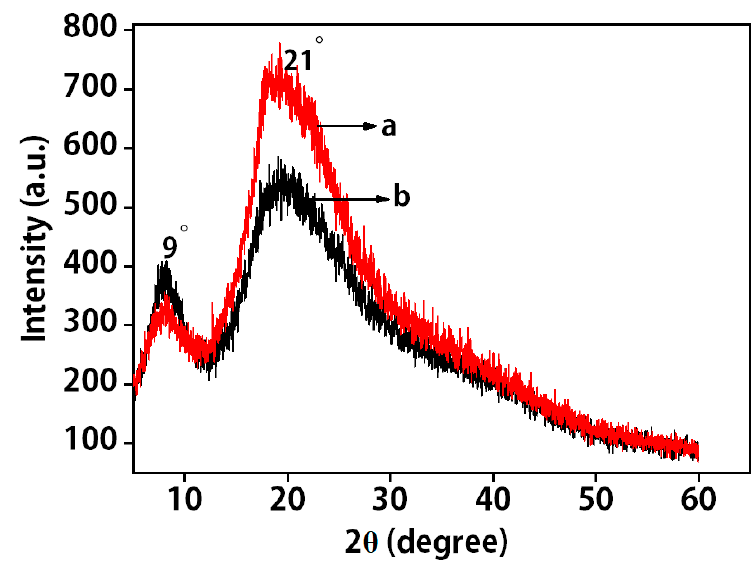
Figure 2. XRD analysis of ( a ) pig nail keratin; ( b ) pig nail powders.